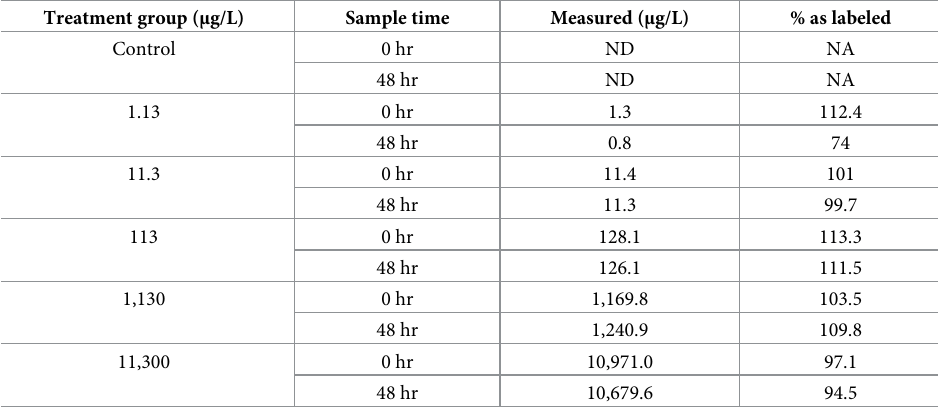
Table 2. Analytical chemistry results of syrup containing